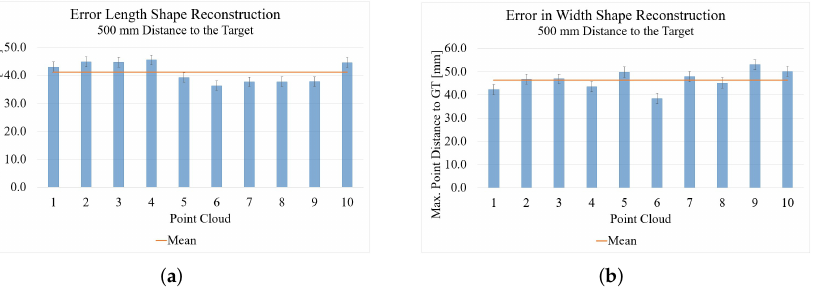
Figure 16. Results of the shape reconstruction of length and width with the Microsoft Kinect Azure: ( a ) length reconstruction; ( b ) width